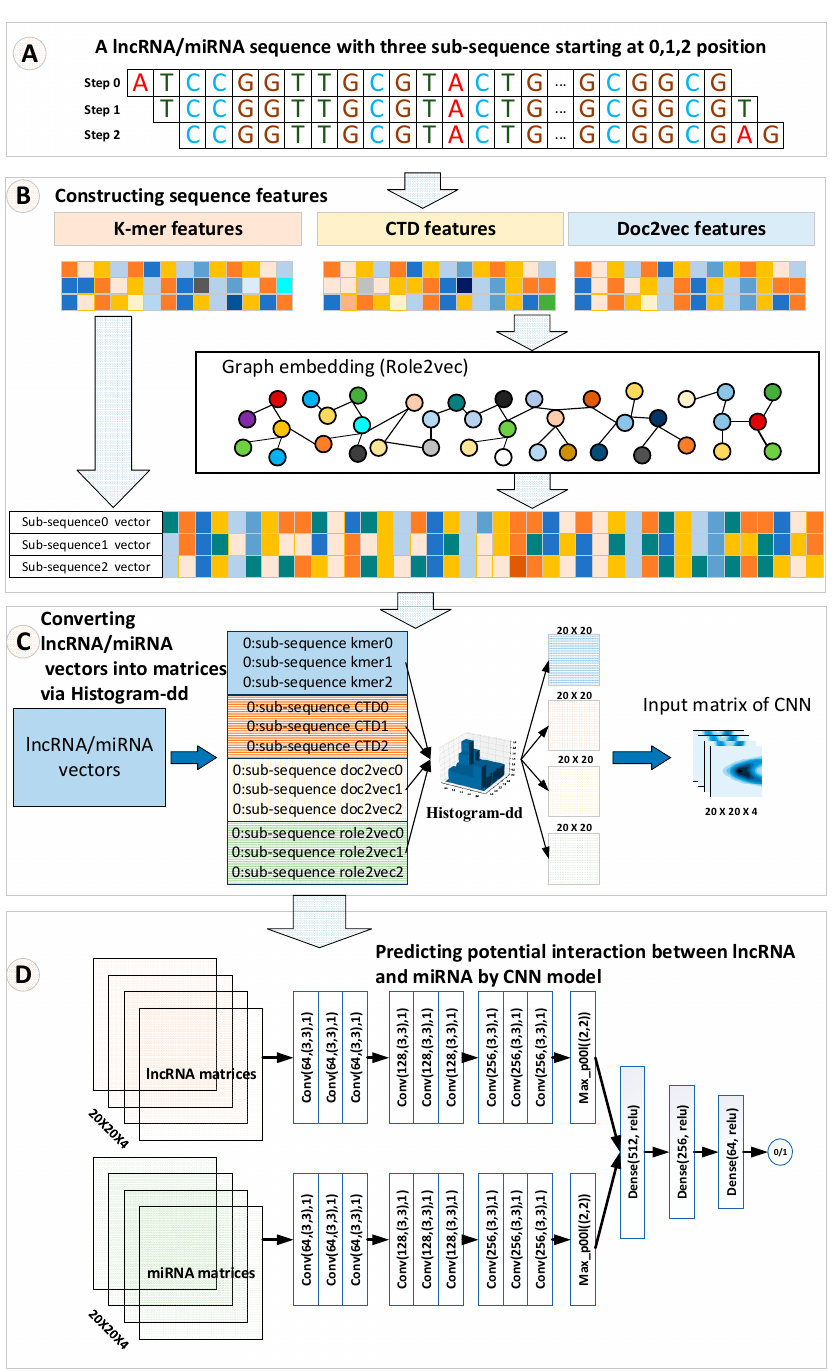
Figure 1. The overall workflow of LncMirNet. ( A ) Sub-sequence of a lncRNA/miRNA starting with position 0, 1, 2 respectively; ( B ) process to construct k-mer, CTD, and doc2vec and graph embedding features; ( C ) process to convert the lncRNA/miRNA vectors into a matrix; ( D ) process to predict potential interaction between lncRNA and miRNA by a CNN model.